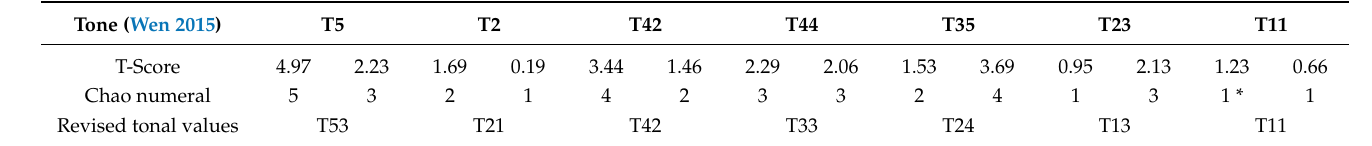
Table 7. T-score and Chao numerals of the seven tones in Xiapu Min (for each tone, the value for the onset is on the left and the value for the offset is on the